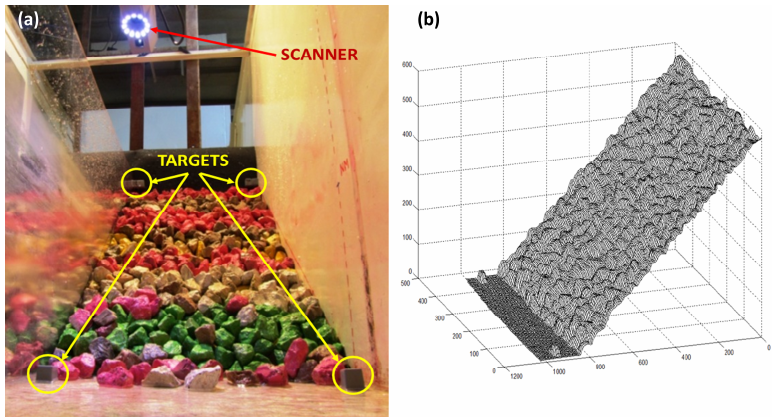
Figure 5. ( a ) Scanning in process (with a structured light scanner) of a drained section as part of damage progression tests carried out at the HRL-UPM of Madrid, Spain; ( b ) Resulting point cloud. Reproduced from Campos [46].